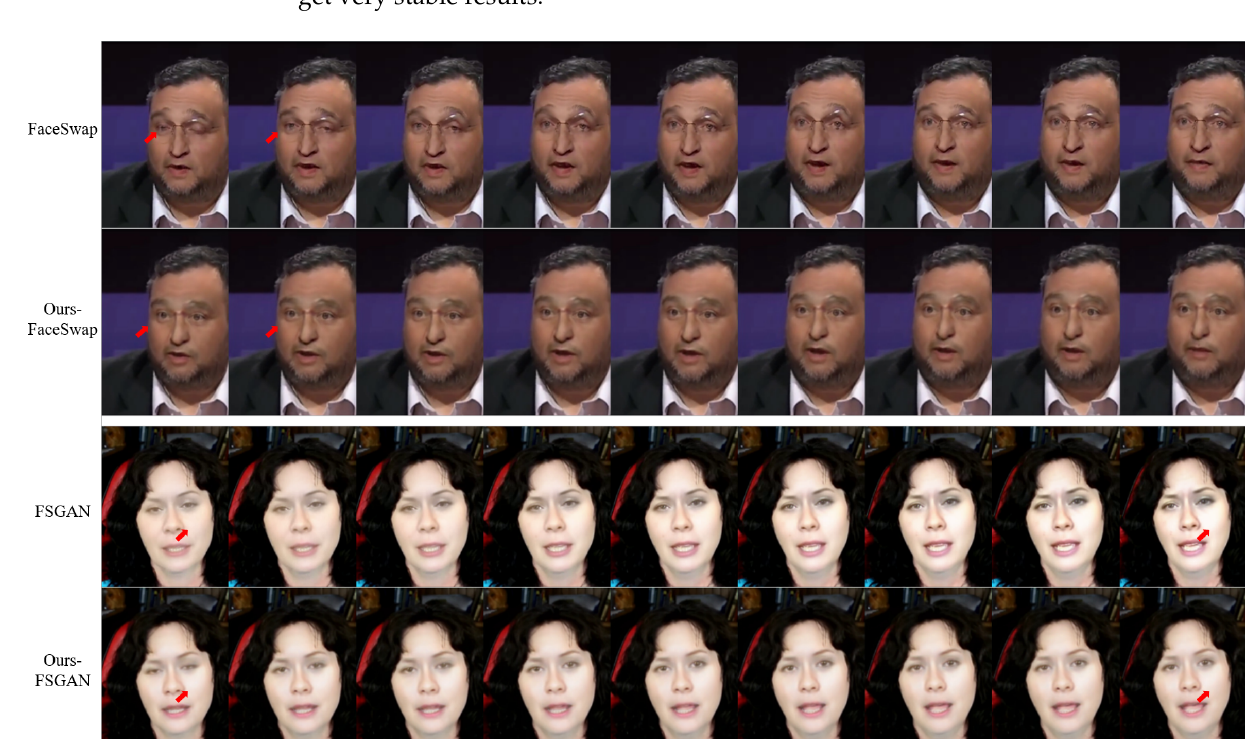
Figure 4. The qualitative evaluation results of our method. The results of FaceSwap are unstable and full of traces of deformation. FSGAN cannot deal with brightness well, which causes bad coherence in the temporal domain. Our method can significantly eliminate the inconsistency in the temporal domain and produce satisfactory